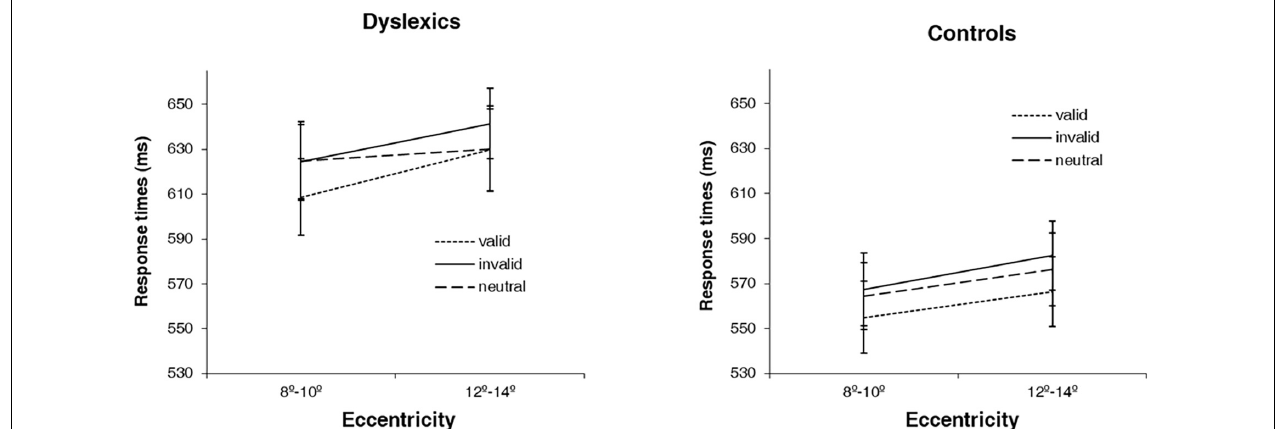
FIGURE 4 | Average response times (ms) for the 3 types of cues (valid, invalid and neutral) at two levels of eccentricity (8 ◦ –10 ◦ and 12 ◦ –14 ◦ ) for dyslexics and controls. Error bars indicate ± SE.